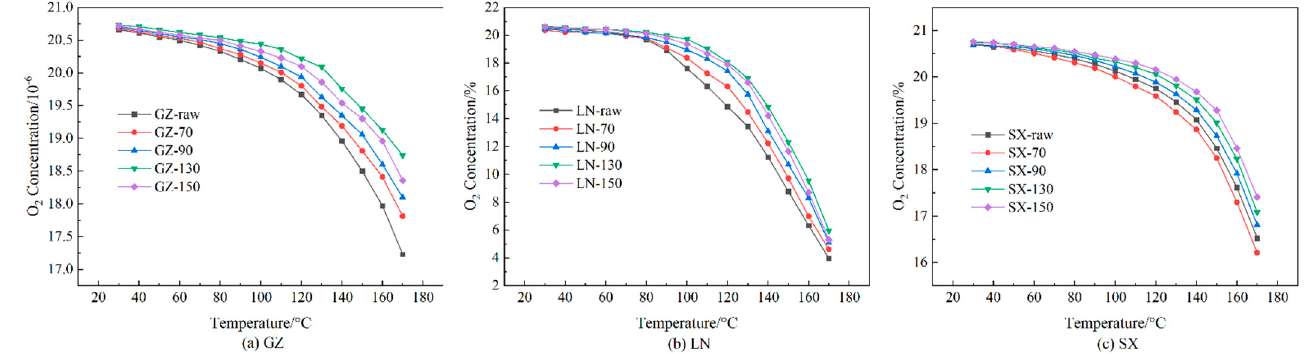
Figure 3. Oxygen concentration at the outlet of different coals during temperature programming: (a) GZ; (b) LN; (c) SX.